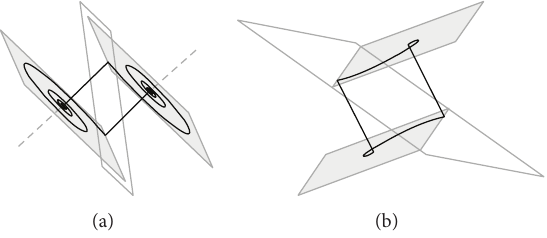
Figure 6: Trajectory close to the heteroclinic orbit for dynamical system cases 𝐴 (a) and 𝐵